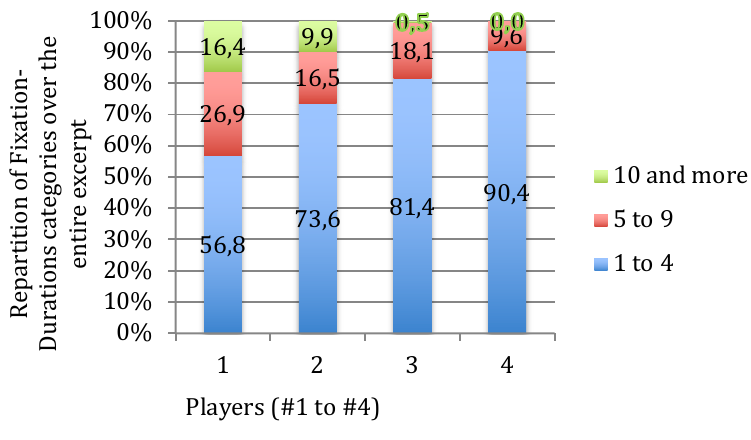
Figure 12. Comparison of Fixation-Duration (in % of total number of fixations over the total excerpt, y-axis) for all players across all tempos for the musical excerpt of ‘Porgy and Bess’. Players are numbered 1 to 4 (x-axis), and Fixation-Durations are grouped in 3 categories: 1 to 4 notes, 5 to 9, 10 and